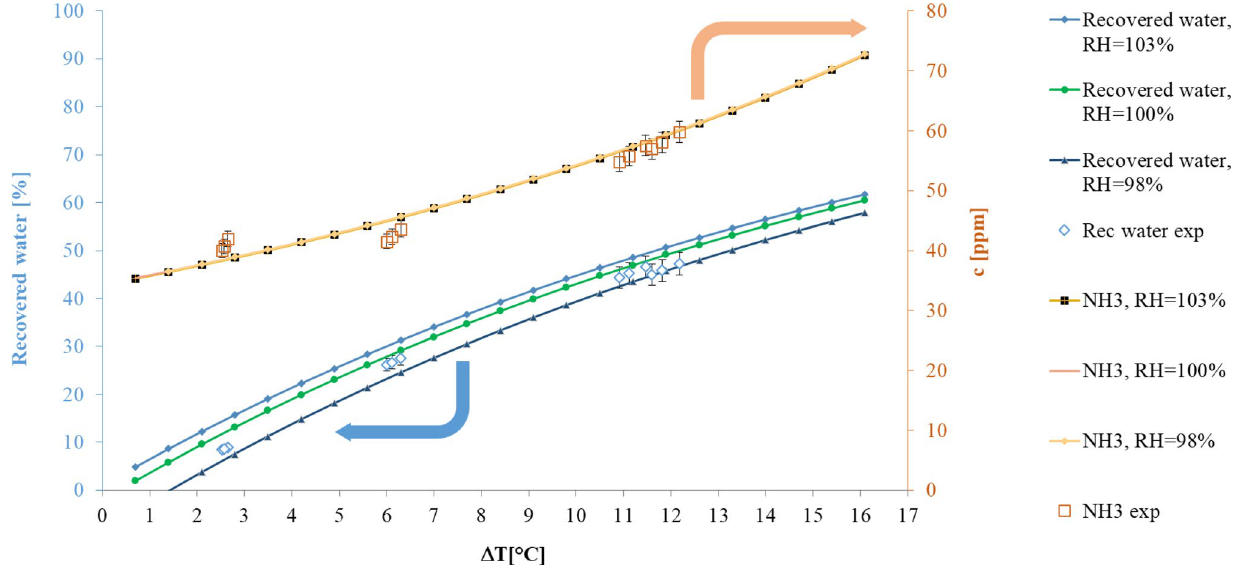
Fig. 3 Recovered water and concentration versus ΔT. Symbols: experimental results; lines: simulation results. (Experimental con- ditions: 98.0% ≤ RH Feed ≤ 103.8%; 34.9 °C ≤ T Feed ≤ 35.3 °C;